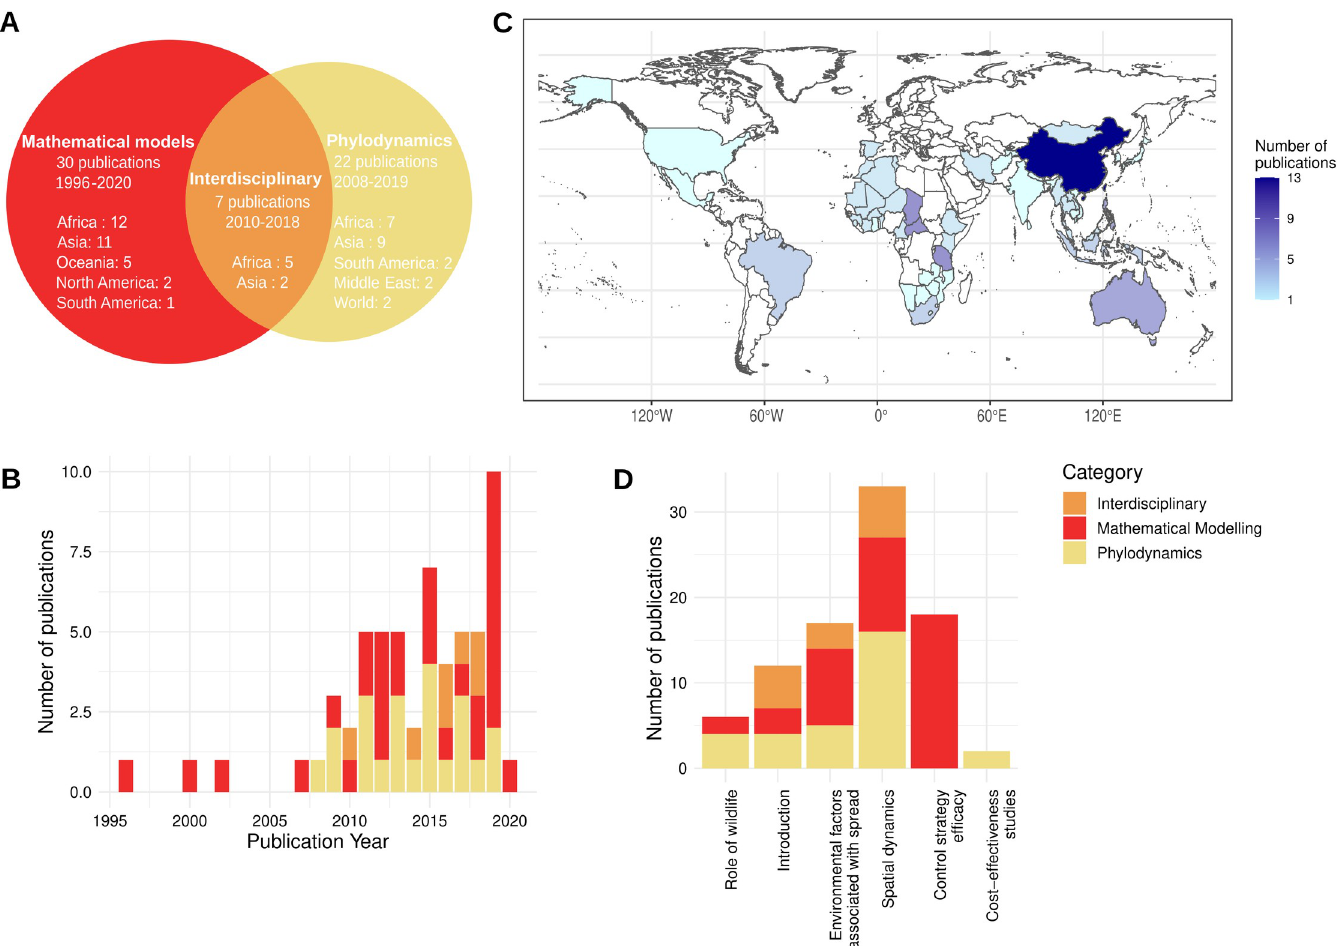
Fig 2. General characteristics of the selected dog rabies studies. (A) Classification of the included publications with the total number of studies, the publication time span, and the number of publications per continent of study. Asia and Africa account for up to 78% of the included studies. (B) Number of publications per year and per methodological category. Mathematical models were the first studies to be published followed by phylodynamic and interdisciplinary studies. (C) Number of publications per country of study. Each publication was attributed to one or multiple countries based on the origin of the RABV genetic sequences, rabid case data or dog ecology data. For phylodynamic studies, countries were not considered if their genetic data were included only in regular phylogenetic tree reconstructions. Similarly, two studies which described rabies dynamics at the global scale [52,65] were not considered in this figure. In our collected records, China accounts for most Asian studies. Spain appears on the map because Ceuta and Melilla, which are Spanish enclaves in North Africa, are represented in two datasets of RABV genetic sequences [68,72]. (D) Number of studies per topic and methodological category. The World Bank, https://datacatalog.worldbank.org/dataset/world-bank-official-boundaries, CC-BY